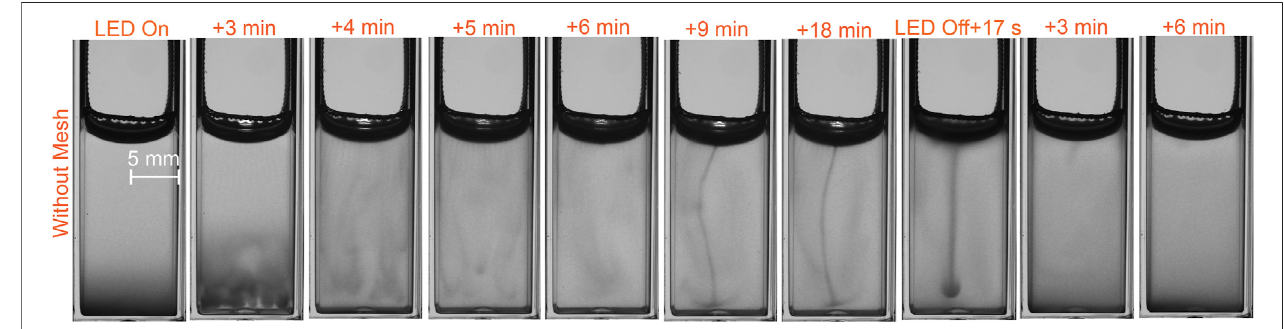
FIGURE 3 | Free surface: photogyrotactic dynamics of a suspension of C. reinhardtii microalgae in a cuvette illuminated from the top by a blue LED, and dynamics when the LED is switched off (last three